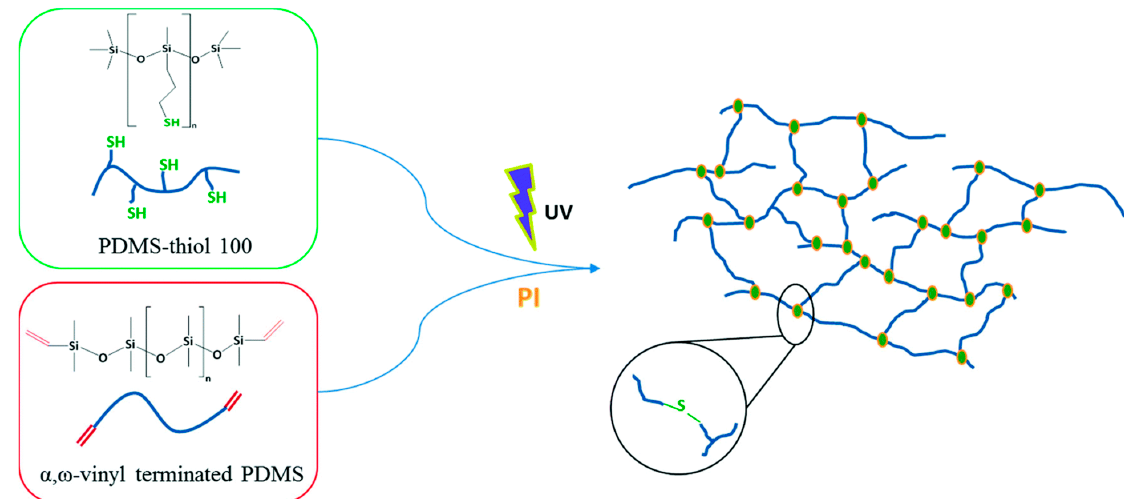
Figure 33. The synthesis of cross-linked polydimethylsiloxane. Republished with permission of Royal Society of Chemistry, © 2016, from Ref. [132].